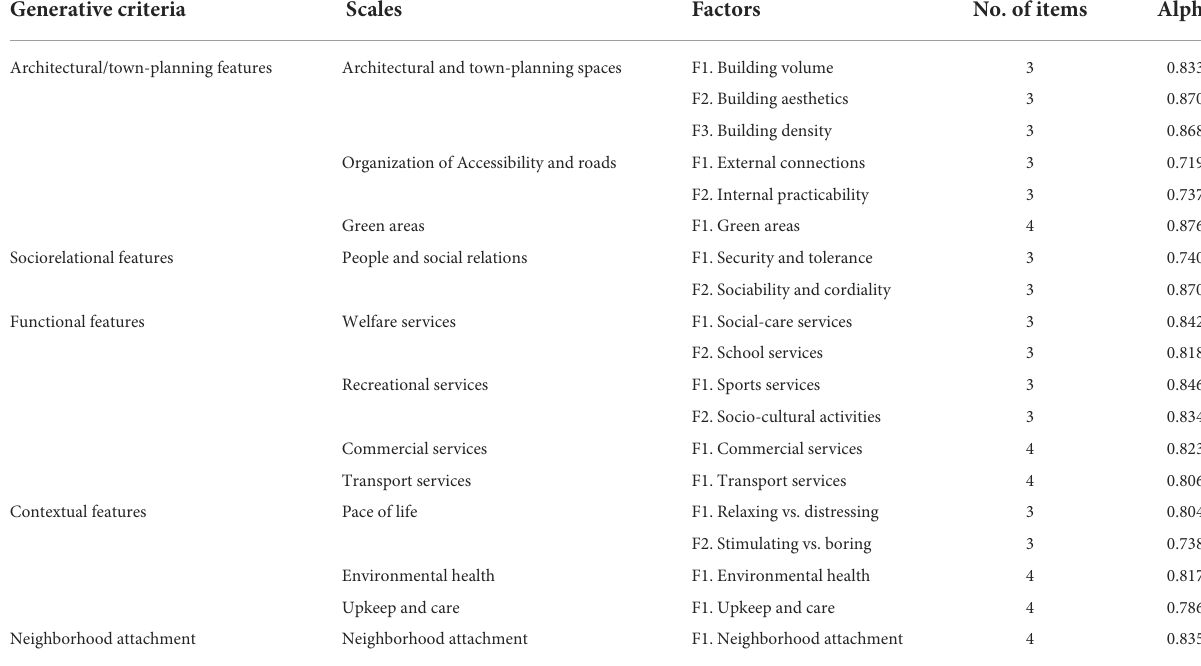
TABLE 4 Summary of the abbreviated version of the Chinese PREQ and NA scales ( N = 1,332). Generative